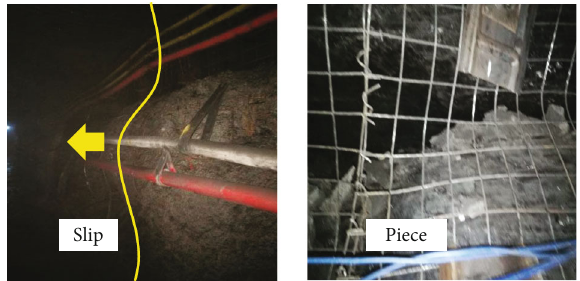
Figure 1: Slip of the sidewalls in